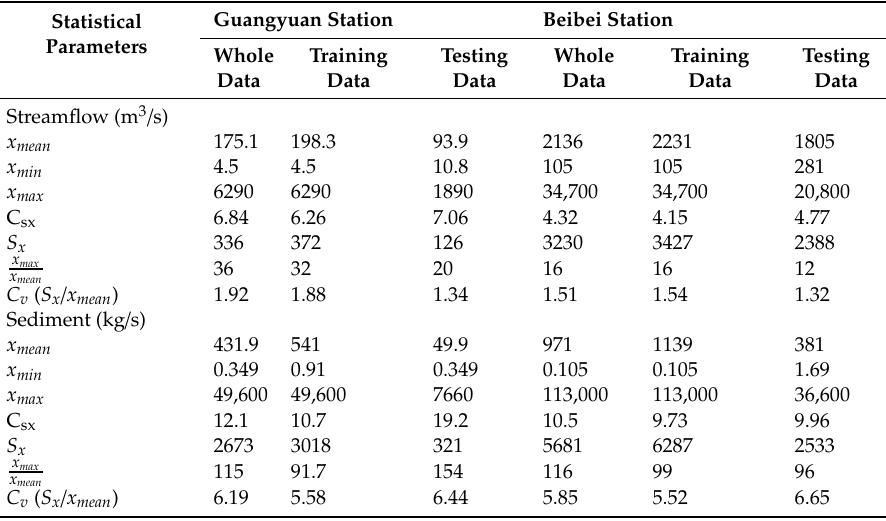
Table 1. The statistical parameters of the applied